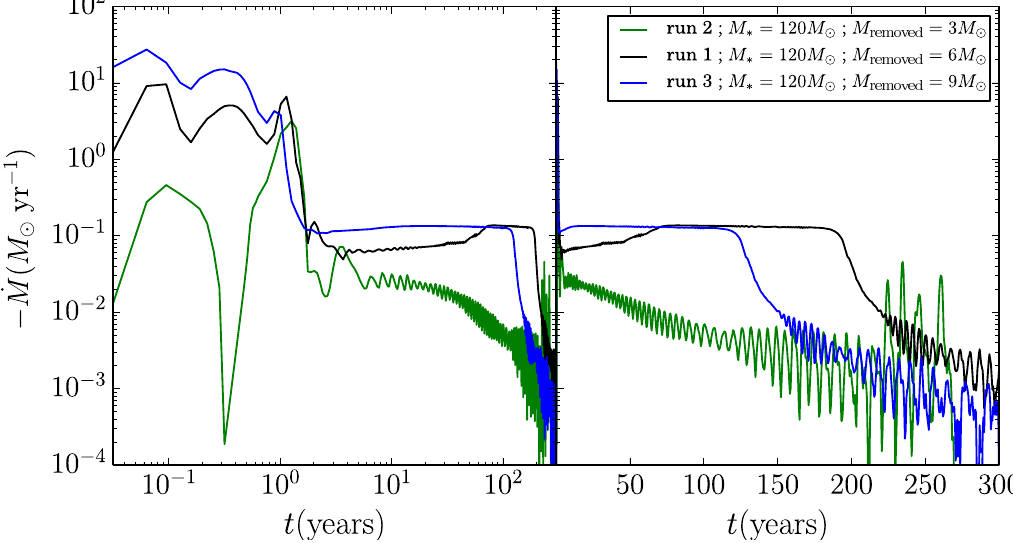
Figure 2. Mass-loss rate as a function of time for runs using the 120 M (cid:12) VMS model and approaching 1 for initiating a GE. The three different lines indicate different simulations with different amounts of mass removed from the VMS. Two of the runs (the blue and black lines) show a change of state in the mass loss rate of about ≈ 130 and ≈ 190 years (respectively) after the GE started. The simulations reproduced the decline in mass loss observed in η Car in previous years, ( ∼ 175 years after its great eruption), during which the rate of mass loss has been declining by a factor of 2–4 (and possibly, continues to